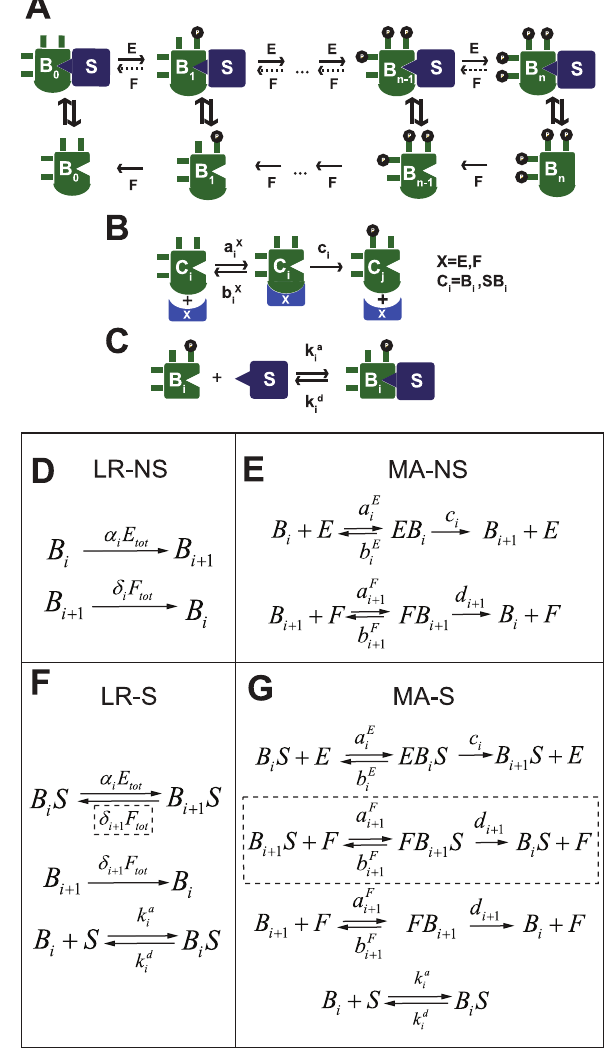
Figure 1. Models of n-site (de)phosphorylation of substrate B with scaffold protein S . A) Phosphorylation occurs only on scaffold- bound substrates, and dephosphorylation can take place both on and off scaffold except when stated otherwise. B i represents a protein that has been phosphorylated i times, and B i F represents the scaffold- bound protein. Phosphorylation is mediated by a kinase E , and dephosphorylation is facilitated by a phosphatase F . B) Full enzymatic (de)phosphorylation mechanism using standard mass action kinetics (MA). The parameters a E , b E , c i represent the on, off, and catalytic rates i i for the phosphorylation reaction. For the dephosphorylation reaction these rates are a F , and d i , respectively. C) Mechanism for scaffold , b F i i binding. The substrate binds with the scaffold to form a heterodimer that can also unbind back to its original form. The parameters k a and k d i i represent the on and off rates, respectively. D–G) We distinguish between models with a scaffold (S) and models with no scaffold (NS), as well as models with full mass action enzymatic reactions (MA) and models with simplified, linear enzymatic reaction rates (LR). This gives rise to the four models MA-S (D), LR-S (E), MA-NS (F), and N LR-S (G). The reactions in the dotted squares are omitted when dephosphorylation only takes place